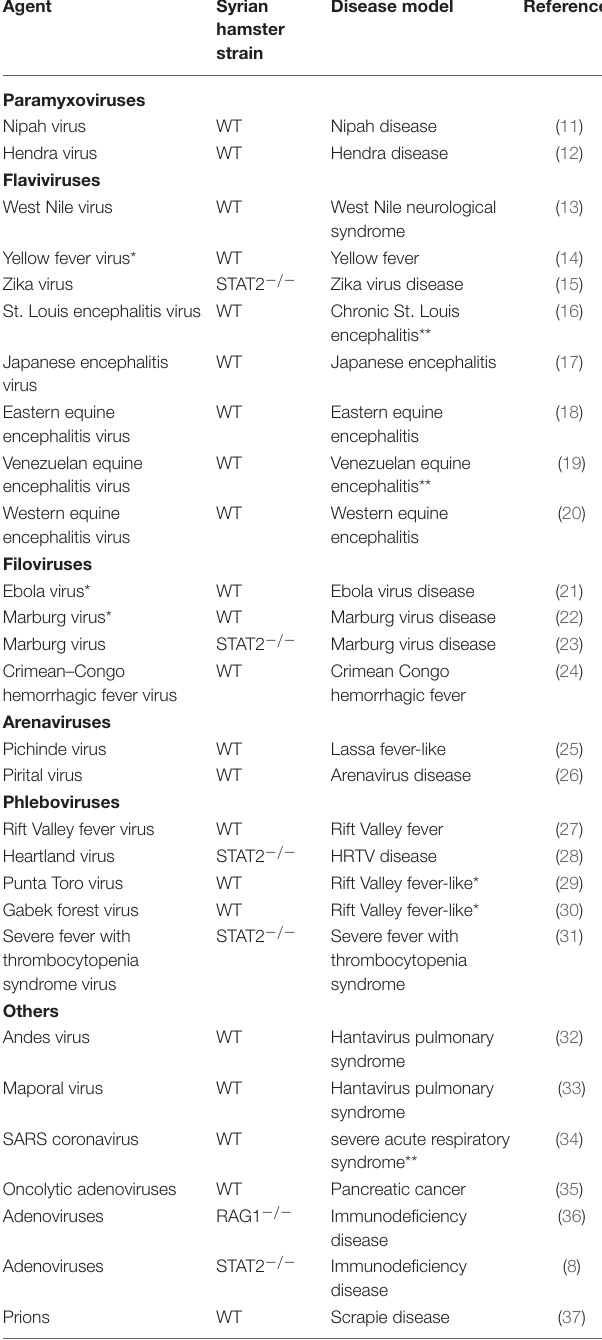
TABLE 1 | Viral infections in Syrian hamster